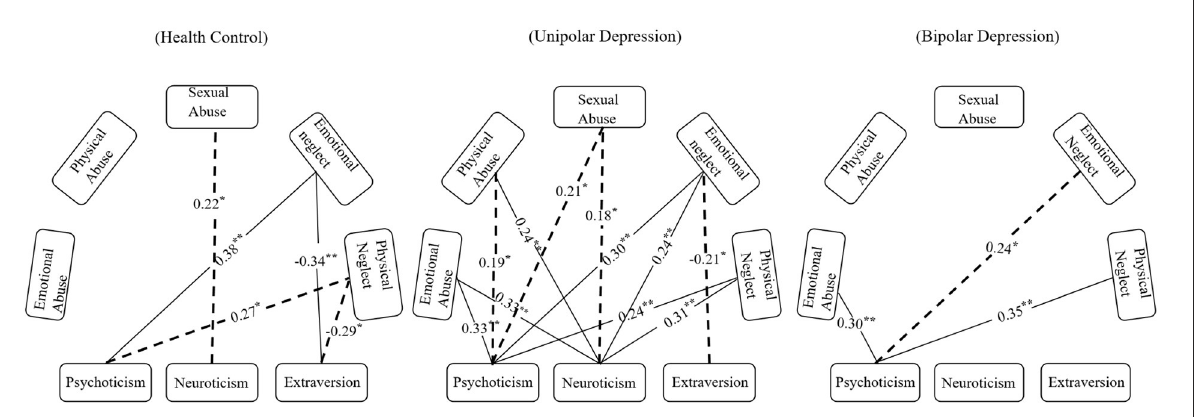
FIGURE2 Spearman’s correlation analysis of childhood trauma and personality among the different groups. The line represents the correlation between childhood trauma and personality surviving the threshold we set for statistical significance, the dotted line indicates the 0.05 significance levels ( P < 0.05) and the solid line indicates the 0.01 significance levels ( P < 0.01).